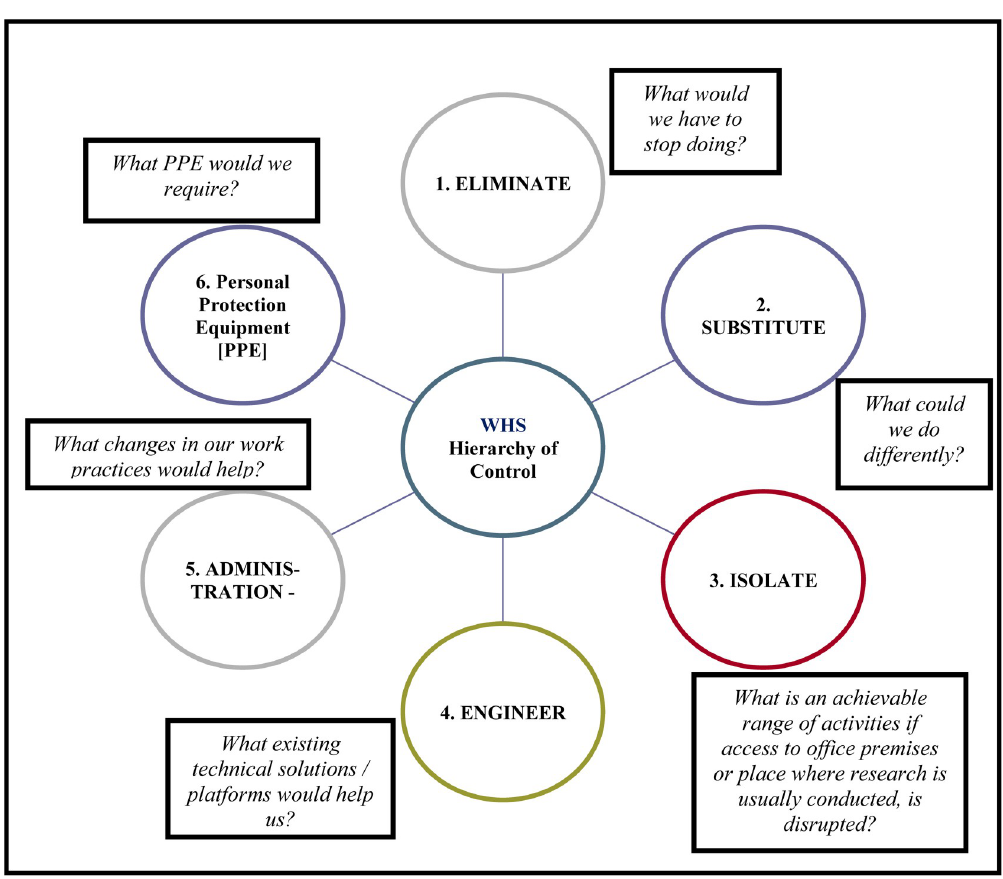
Fig 4. Work Health and Safety (WHS) Hierarchy of